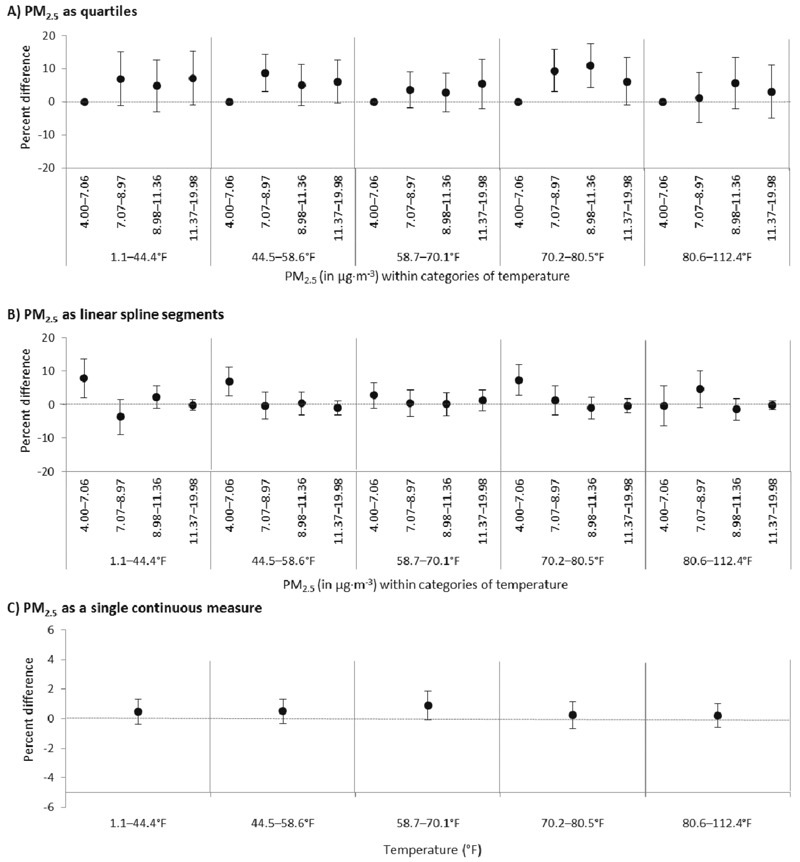
Associations between particulate matter ≤ 2.5 μm in diameter (PM2.5) and the prevalence of asthma symptoms in the past 14 days among adults with active asthma across quintiles of air temperature. Results are shown for temperature category-stratified models in which PM2.5 is parameterized as quartiles (A), four linear spline segments (B), and a single continuous measure (C). All models are adjusted for individual- and county-level covariates. Formula for conversion from degrees Fahrenheit (TF) to degrees Celsius (TC): TC = (TF – 32) × (5/9).